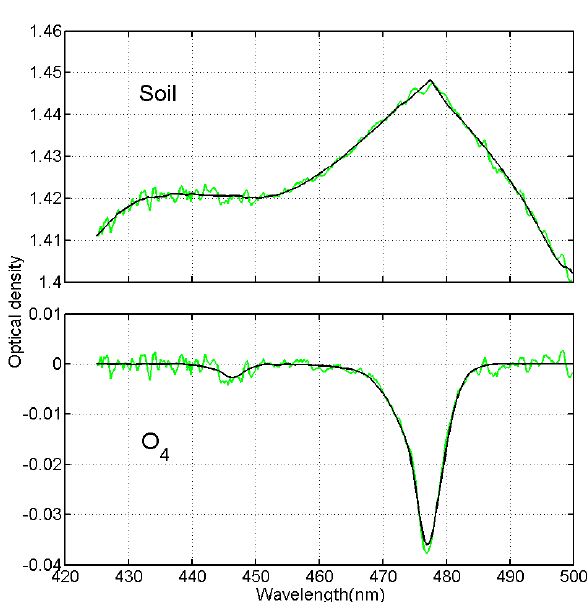
Fig. 14. Soil signature in the spectra over the Arabian desert (upper panel). For comparison, the O 4 signature is displayed in the lower panel.